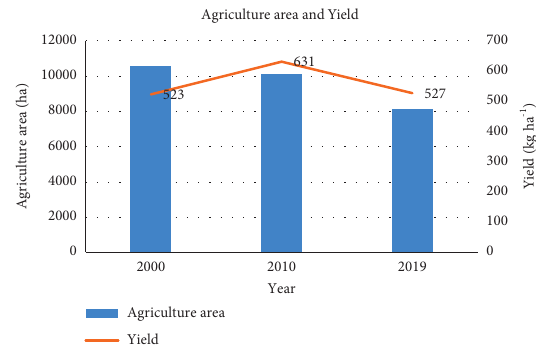
Figure 5: The graph showing agriculture area and yield obtained. Table 6: Regression coefficients of the variables.